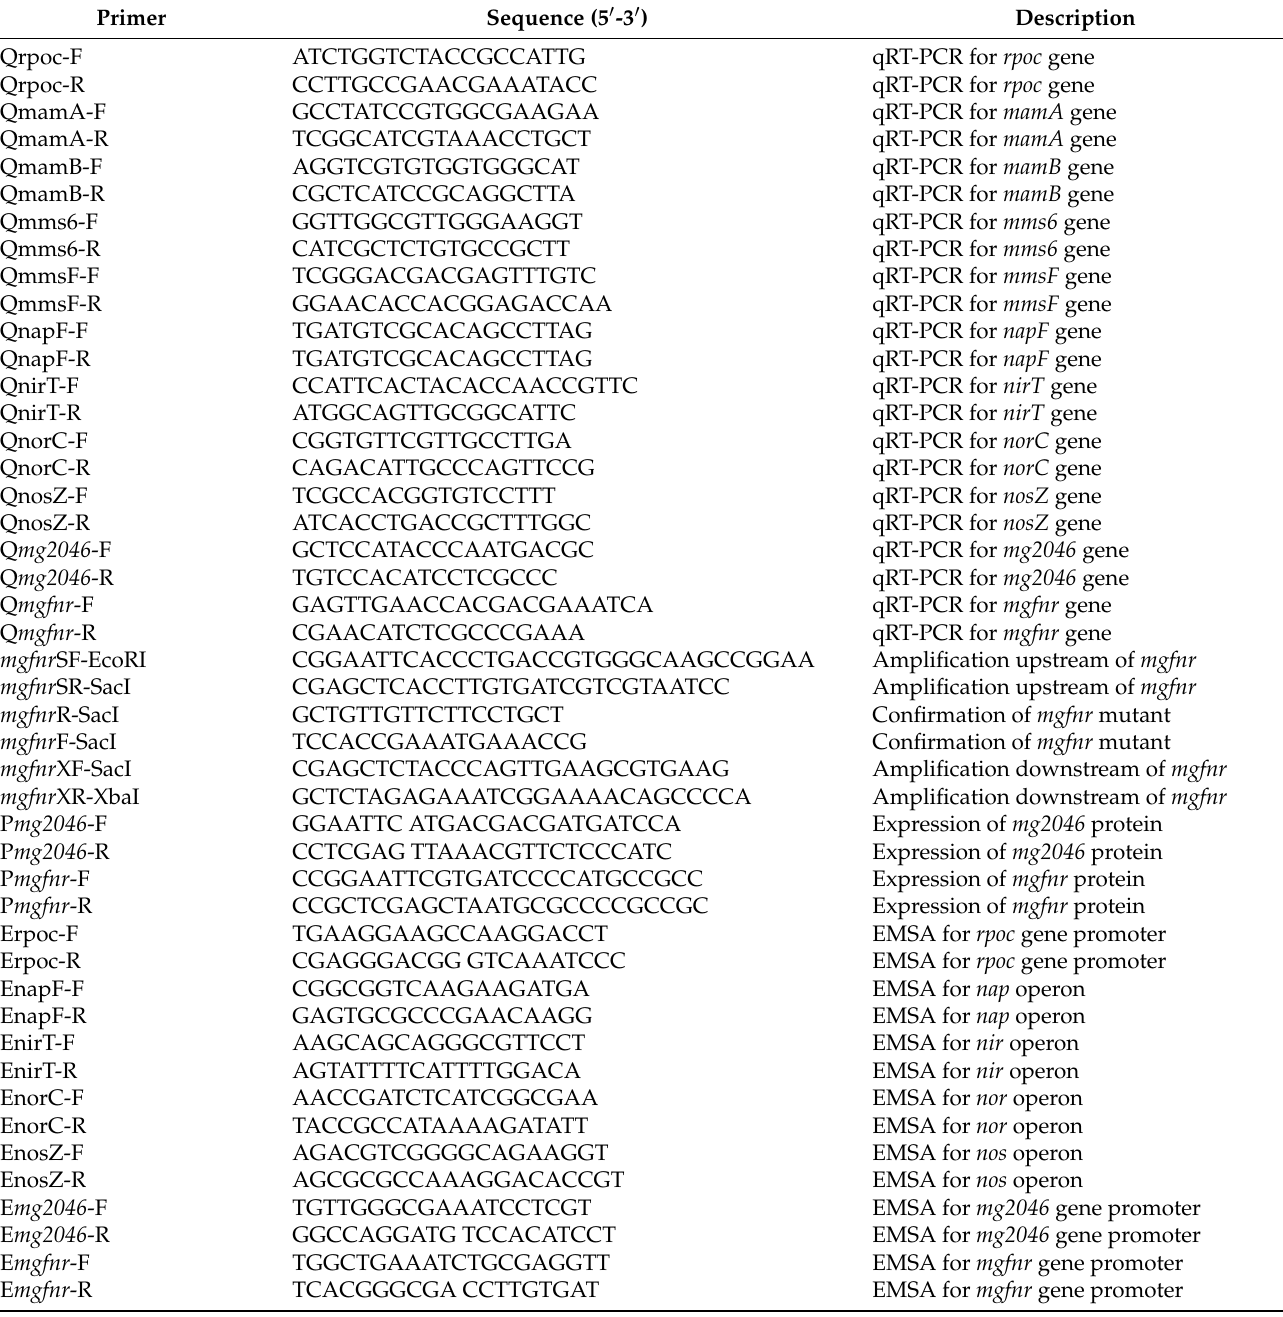
Table 1. Primers used in this